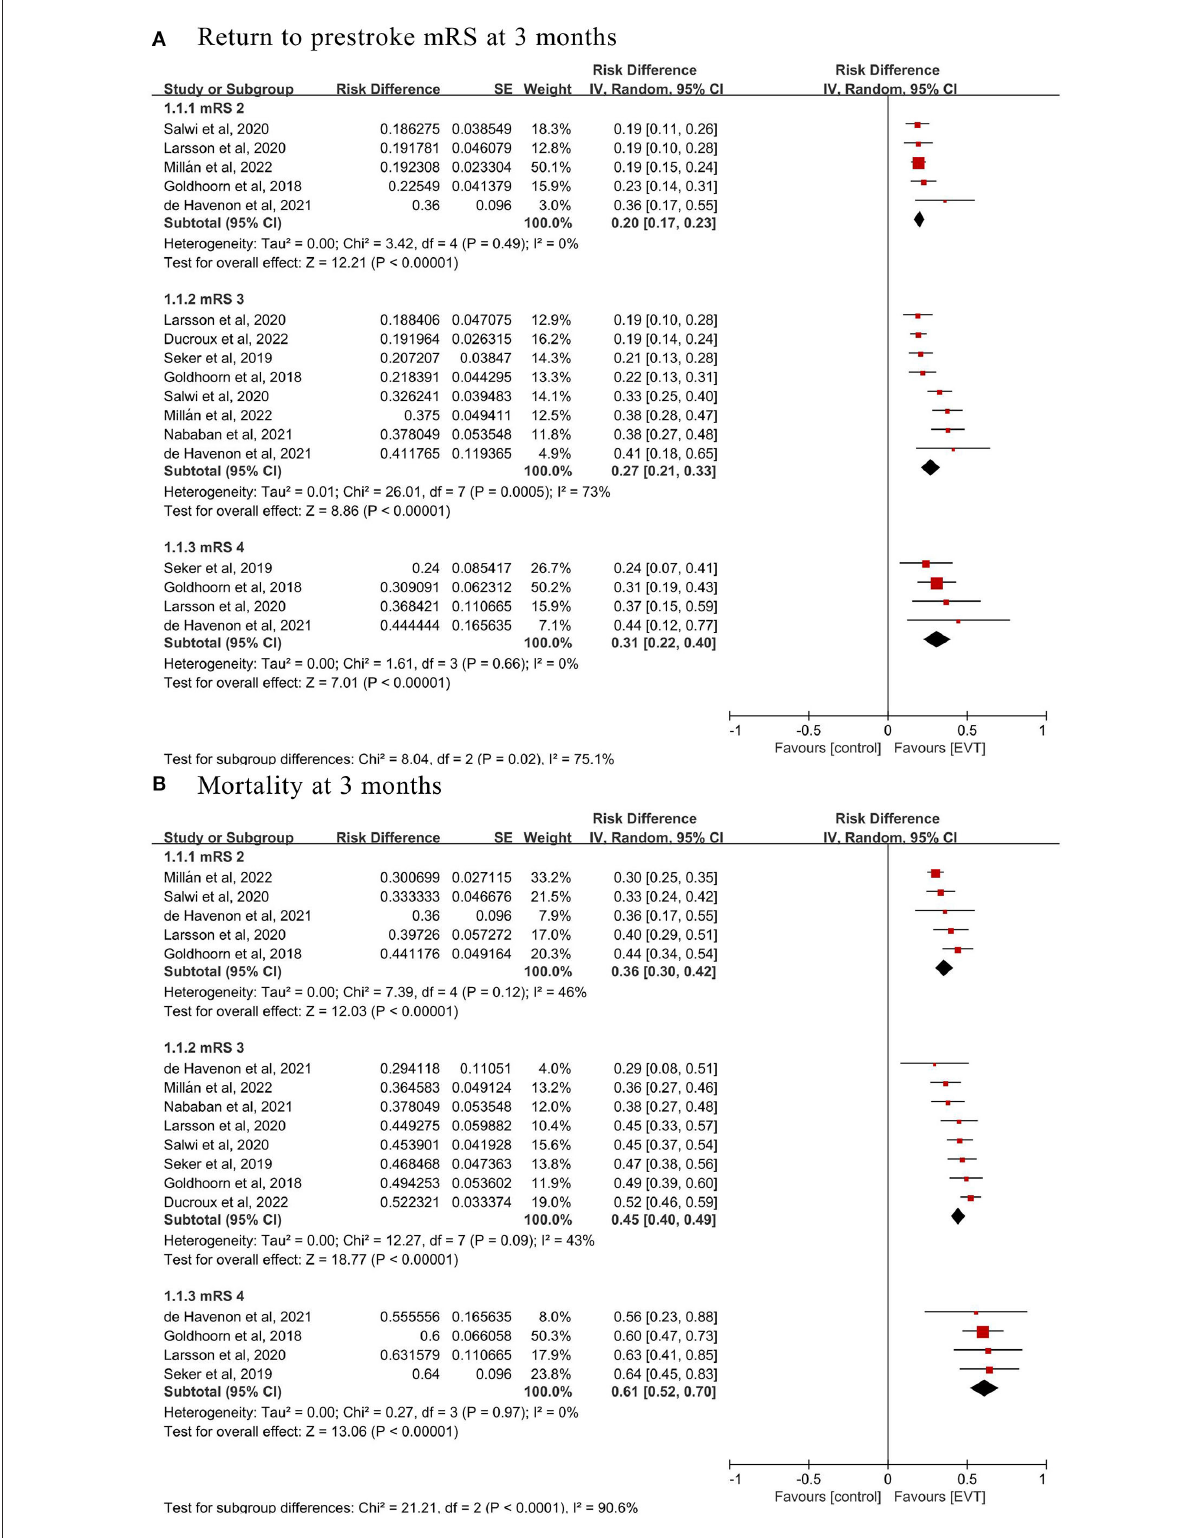
FIGURE2 Pooled incidence of (A) return to prestroke modified Rankin Scale (mRS) and (B) mortality at 3 months in prestroke disability patients treated with endovascular thrombectomy